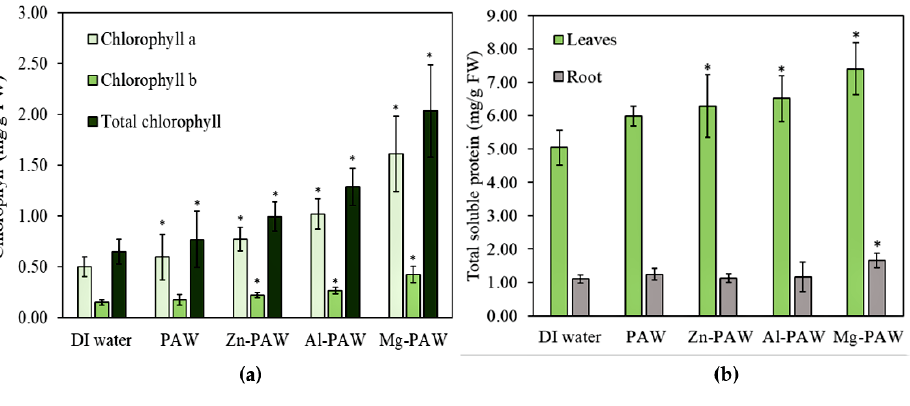
Figure 7. ( a ) Chlorophyll content in leaves and ( b ) total soluble protein content in leaves and roots of fresh corn plants after the 10th day of soaking in DI water, PAW, PAW with Zn (Zn-PAW), PAW with Al (Al-PAW), or PAW with Mg (Mg-PAW). The symbol ∗ represents a t-test result with a significance level greater than